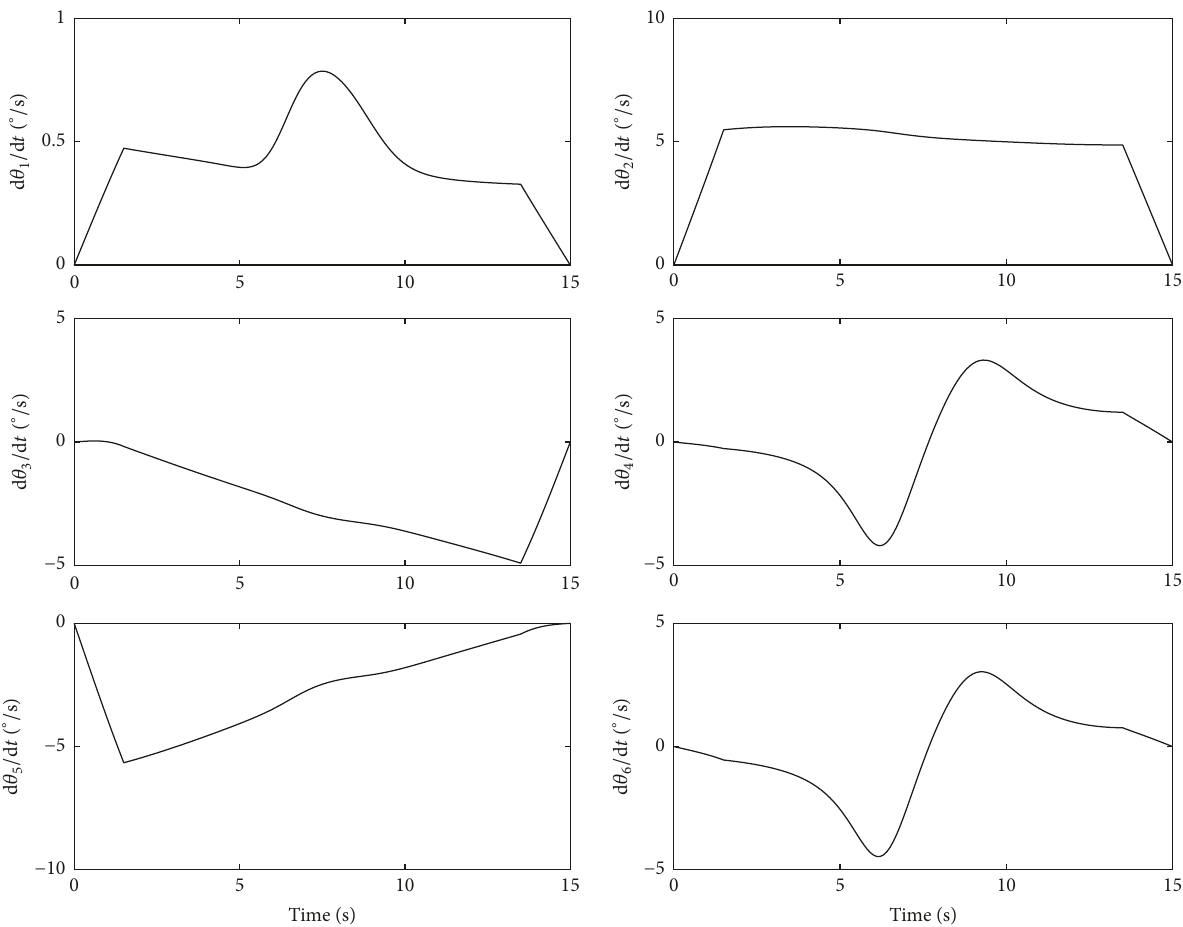
Figure 9: The joint velocity path planned by singularity-robust algorithm based on